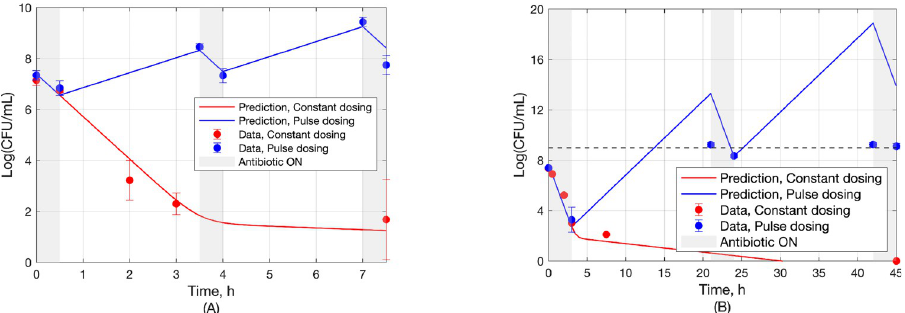
Fig 8. Experimental values (dots) and model predictions (lines) for constant dosing (red) and pulse dosing with t off / t on = 6 > ( t off / t on ) c (blue) for (a) { t on , t off } = {0.5h, 3h} and (b) { t on , t off } = {3h, 18h}.